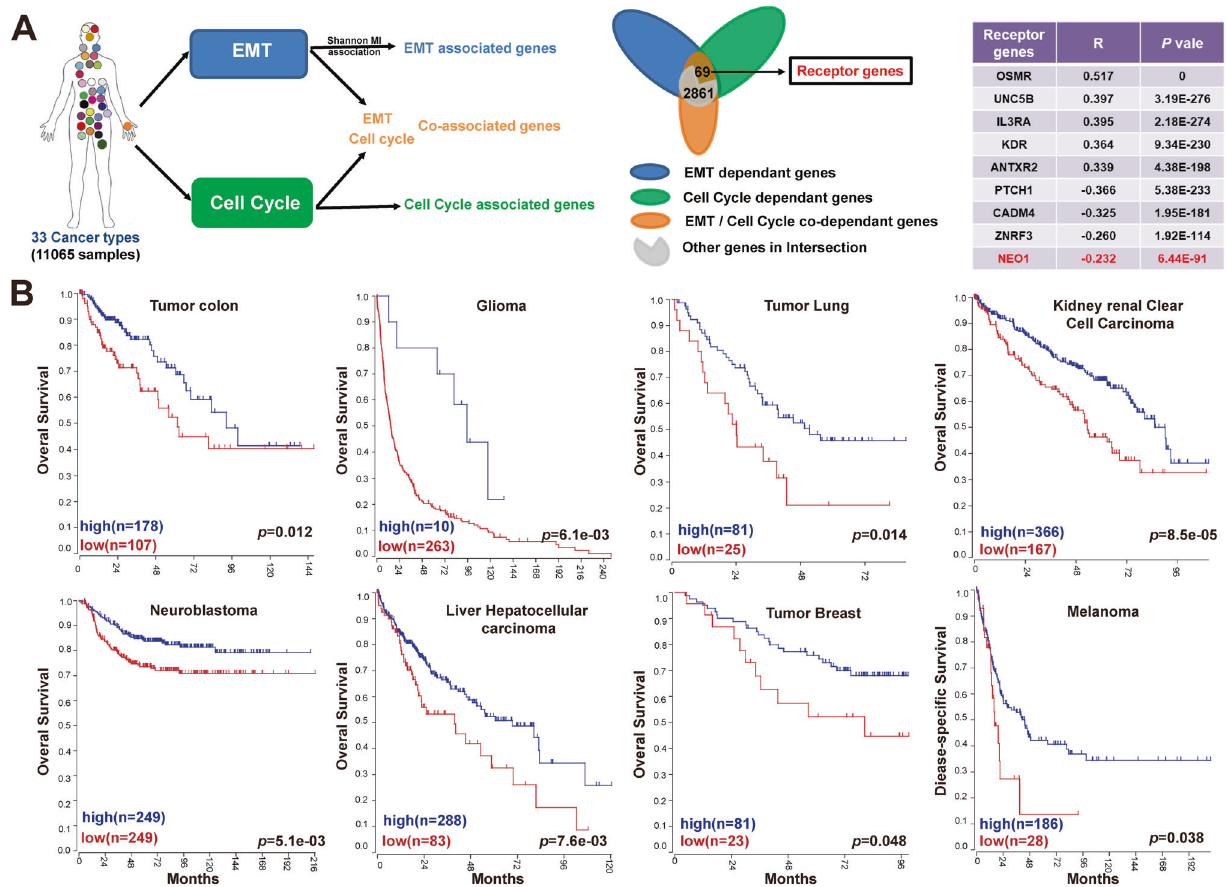
Fig. 1 Enrichment of epithelial-mesenchymal transformation-related genes from 33 cancer types. A Gene expression data of 33 types of cancer were extracted from the TCGA dataset. The GO-bioprocess plot was generated by three major bio-functions: EMT, cell cycle, EMT and cell cycle process. As a result, 2930 genes signi fi cantly enriched in the intersection, with 69 receptor genes participating in the above three processes. The most signi fi cant positive and negative receptor genes were shown in the right table, and NEO1 was among them. B Overall Survival information and gene expression data of eight types of cancer patients were extracted from the TCGA dataset. The eight types of tumors involved are as follows: Tumor colon, glioma, tumor lung, kidney renal clear cell carcinoma, neuroblastoma, liver hepatocellular carcinoma, tumor breast, and melanoma. To describe the contribution of NEO1 to patient survival time, we used Kaplan – Meier analysis. 95% CI and p value were calculated via log-rank test and shown at the bottom of each plot. Neogenin have the poorest prognosis (Fig. 2B, C). Furthermore, we three processes (Fig. 1A and Supplementary Table S4). Further- quanti fi ed the expression of NEO1 between tumor tissue and more, the nonlinear monotonic association of these 69 receptors with the EMT score and mitotic score was analyzed by Spearman analysis, separately. Among the 69 receptor genes, most of the top EMT correlated receptor genes have been previously validated, such as OSMR, UNC5B, SEMA3F, and NOTCH2 [13 – 15], but rarely associated with the cell cycle in our association analysis. However, the top inversely correlated receptor genes with EMT also have negative regulatory relationships with mitotic activity, such as PTCH1, CADM4, ZNRF3, NEO1, etc. [16, 17] Here, we also found that NEO1 contributes signi fi cantly to EMT progress in 33 tumor models (Fig. 1A). To explore the role of NEO1 in cancer, we fi rst analyzed the expression of Neogenin in eight tumor models, including tumor colon, glioma, tumor lung, kidney renal clear cell carcinoma, tary Table S5). Among all these tumor types, lower Neogenin expression predicts poorer overall survival (Fig. 1B). To further con fi rm the potential inhibitory function of Neogenin at the protein level, we collected 167 CRC biopsies and analyzed the protein expression of NEO1 by IHC (Fig. 2A and Supplementary Table S1). Among all cases, CRC patients with low expression of Cell Death Discovery (2023)